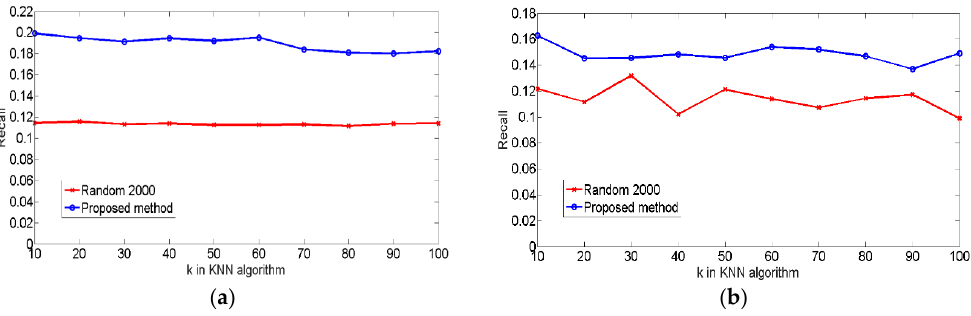
Figure 3. ( a ) Recall criterion with similarity measures of cosine; ( b ) Recall criterion with similarity measures of NHSM.